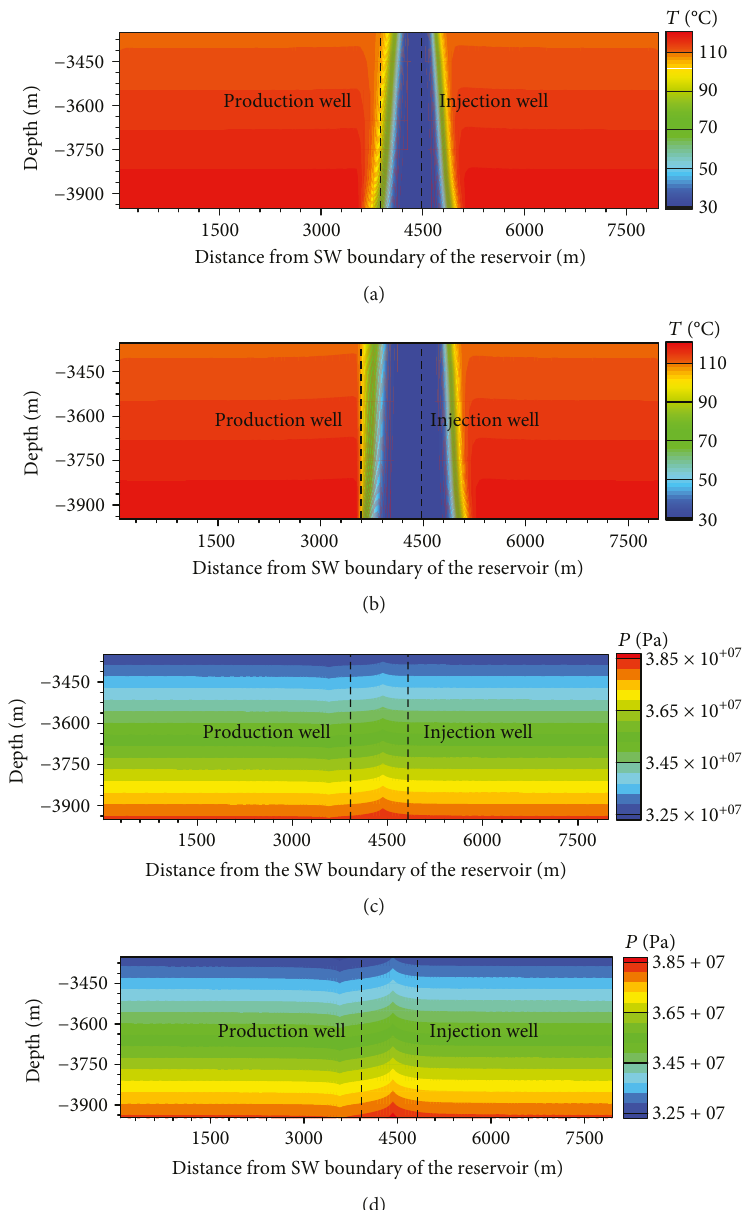
Figure 7: Temperature (a) and pressure (c) fi eld distributions at the injection/production rate of 450 m 3 /h, and temperature (b) and pressure (d) fi eld distributions at the injection/production rate of 900 m 3 /h along a 2D SW-NE trending cross section of the reservoir (50 years). Black dotted lines represents the location of injection well and production